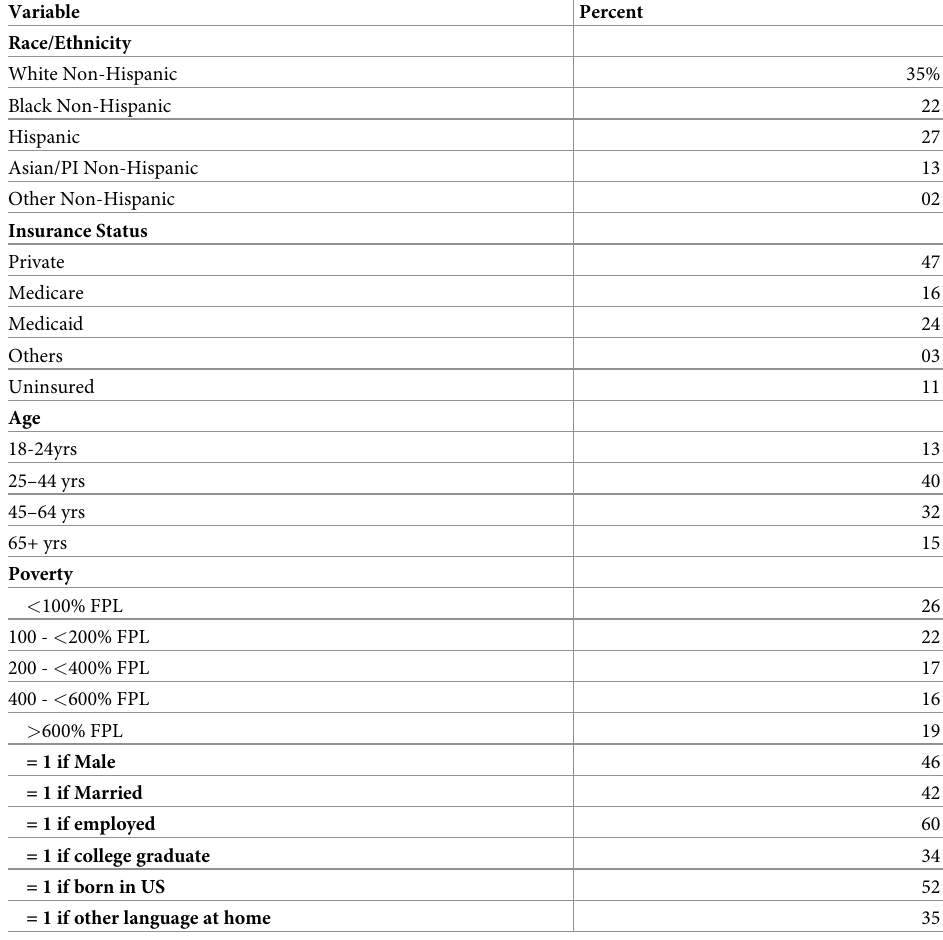
Table 1. Summary statistics– 2016 NYC Community Health Survey